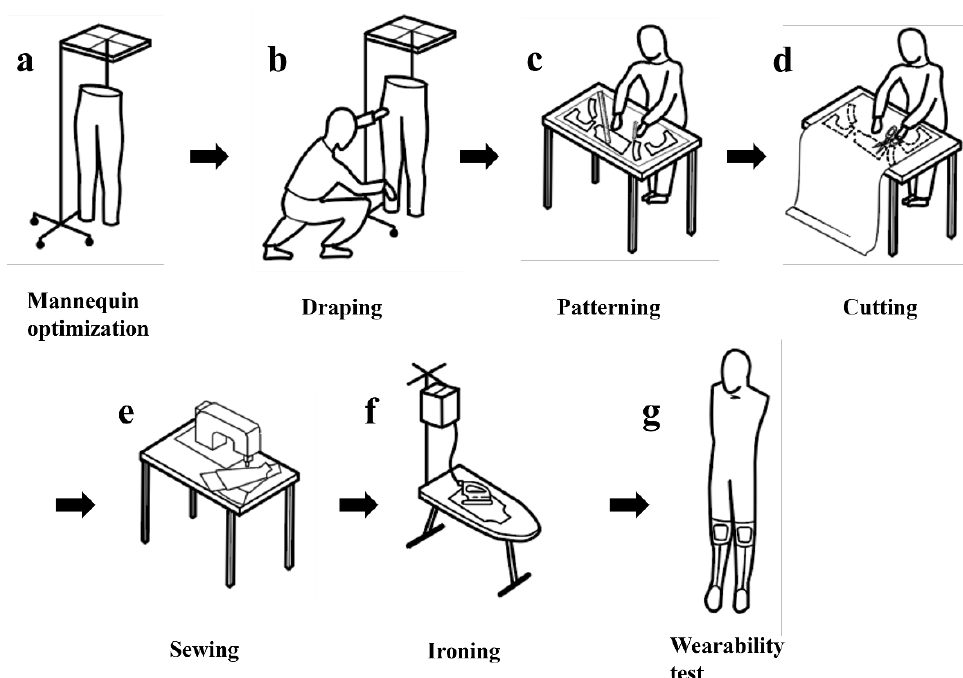
Figure 7. kneE-XOcks was manufactured through a seven-step manufacturing process. After opti- mizing the mannequin to fit the target dimensions, each pattern is created using the draping method. After converting the three-dimensional pattern obtained through this process into a flat pattern, pieces of fabric suitable for each pattern are cut out. After sewing these and connecting them into one garment, finishing work such as ironing is performed. Finally, the kneE-XOcks are completed by reflecting the feedback obtained through the wearability test.